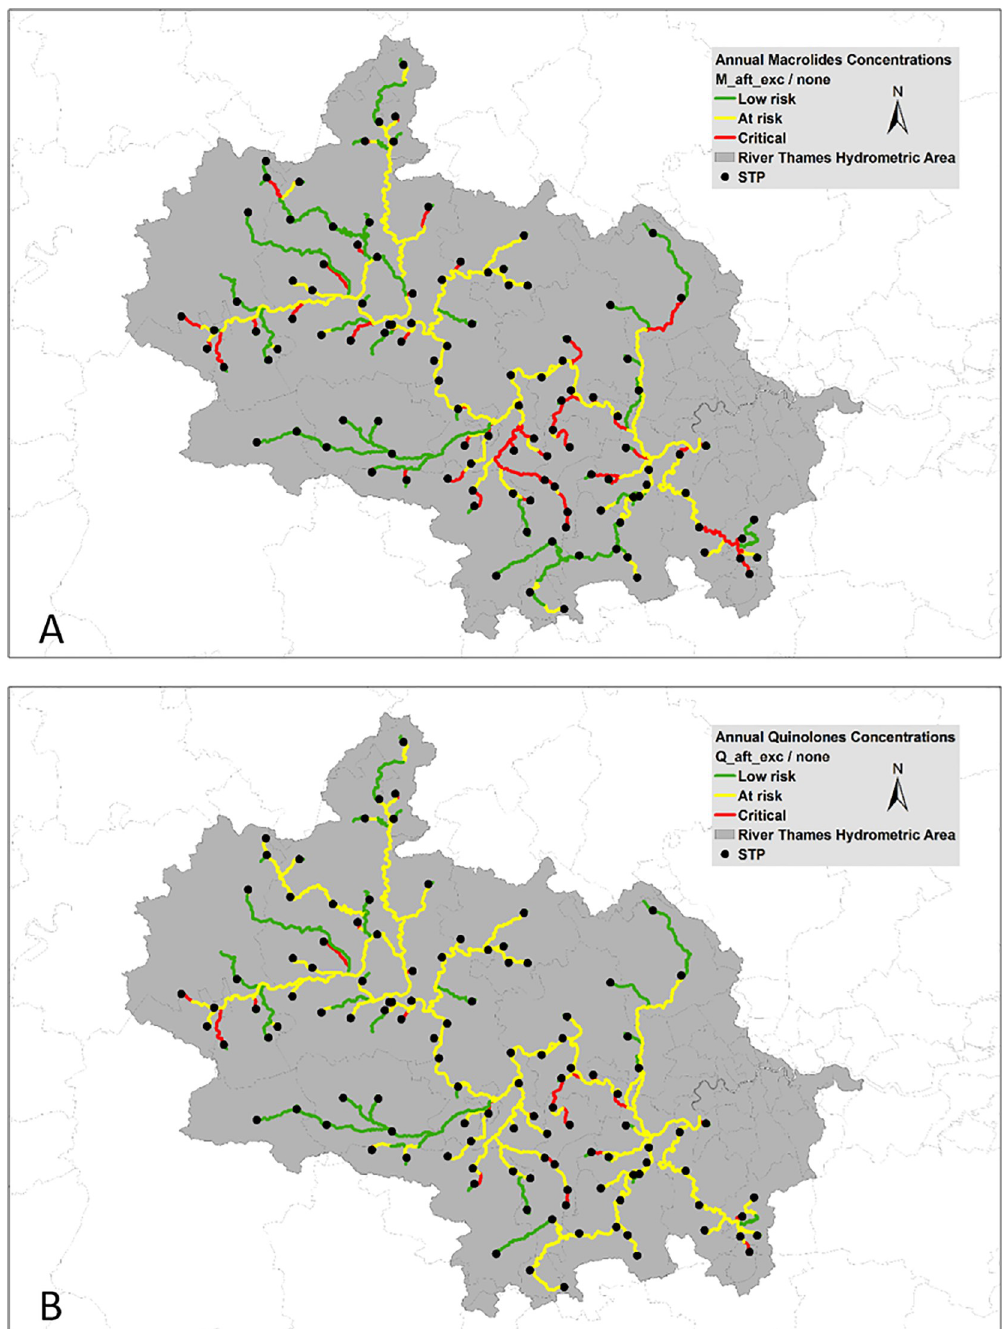
Fig 3. Resistance selection risk characterisation for (A) macrolides and (B) fluoroquinolones using 2015/16 prescription statistics.